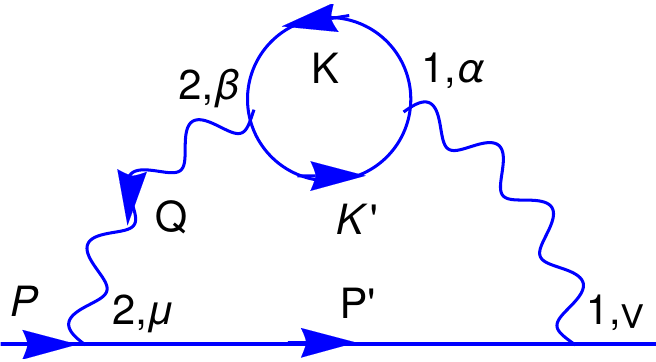
Figure 2 . Self-energy of probe fermion from Coulomb scattering with medium fermion. The massive probe fermion carries momentum P and the massless medium fermions run in the